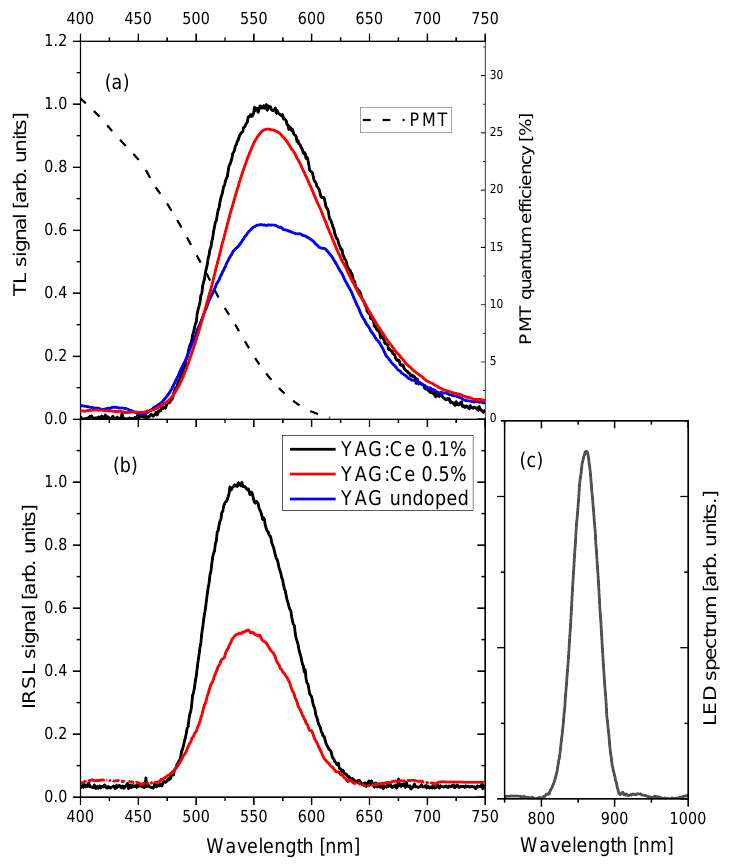
Figure 14. TL ( a ) and IRSL ( b ) emission spectra of the studied YAG crystals (dose 100 Gy). IRSL measurements performed with the application of the BG-39 filter. IRSL signal of the undoped YAG was too low to enable spectral measurements. The black dashed line in panel ( a ) illustrates the quantum efficiency of the photomultiplier of the DA-20 reader. Panel ( c ) presents the measured emission spectrum of LEDs used for the stimulation.